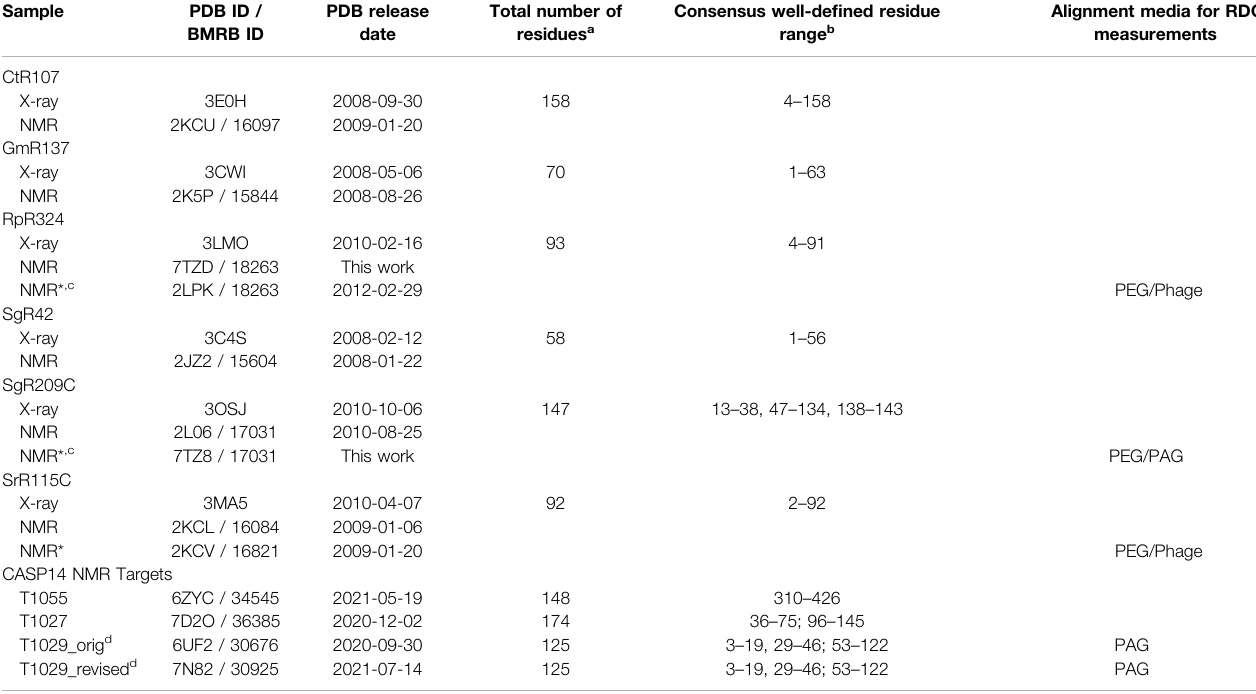
TABLE 1 | NMR and X-ray crystal structures used in this study.